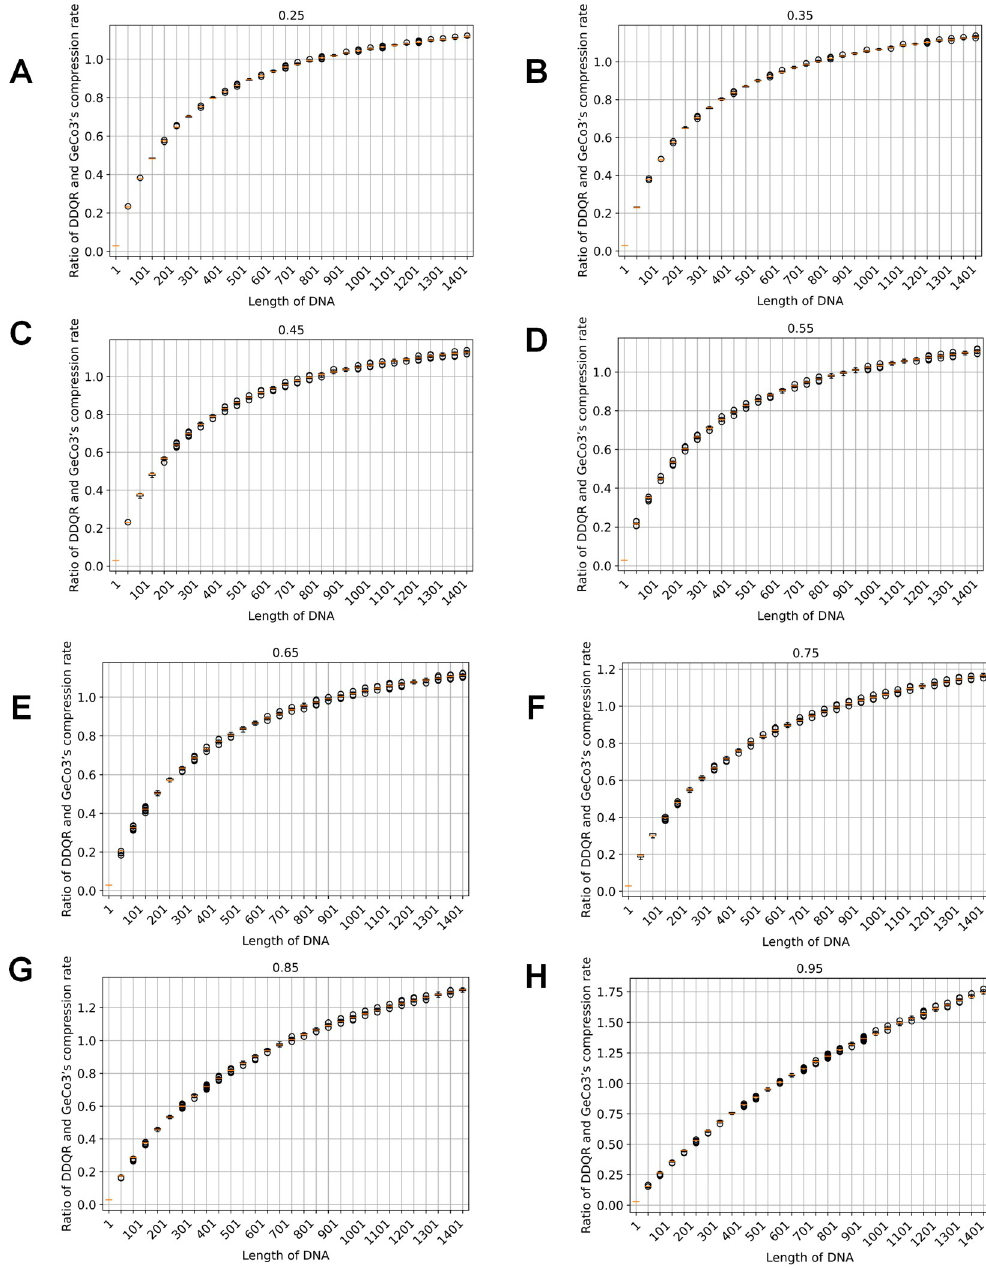
Fig 1. Comparison of compression rates of DDQR and Geco3 using simulated data. The panels represent results obtained for DNA sequences having a particular composition: 25% (A), 35% (B), 45% (C), 55% (D), 65% (E), 75% (F), 85% (G), 95% (H). The x-axis is the DNA sequence length. The y-axis is the ratio of DDQR and GeCo3’s compression